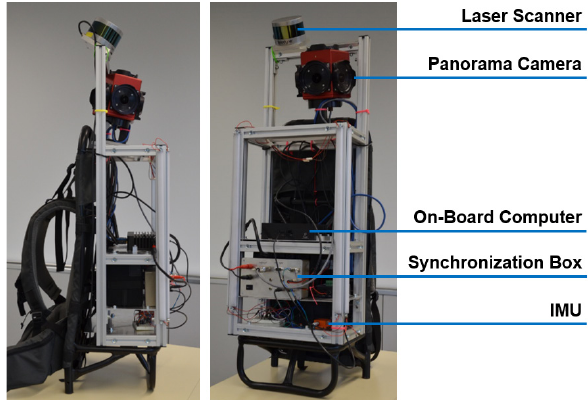
Figure 6. Sensor configuration of our portable panoramic